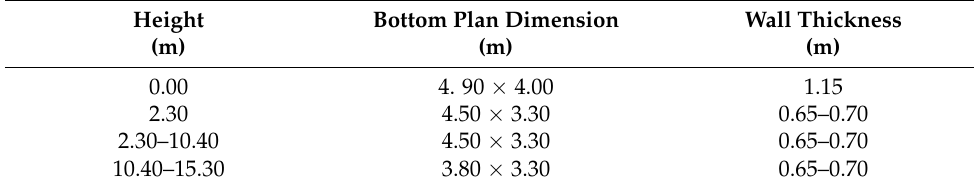
Table 1. Geometric dimensions of the San Giuseppe